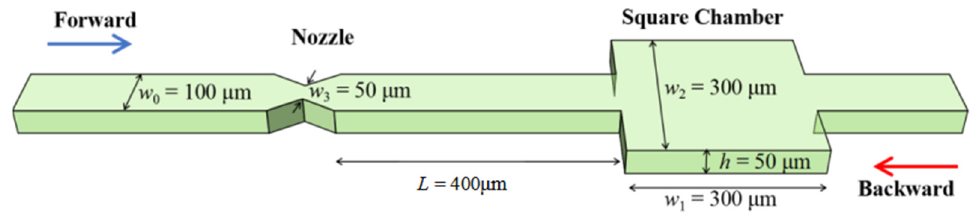
Figure 1. Schematic of microchannel consisting of a square chamber and nozzle structure. The streamline of the flow was recorded under a microscope by adding polystyrene tracking particles with a diameter of 1 µ m in a concentration of 0.6 µ L/mL. The flow pattern was studied at different flow rates and, therefore, different Wi numbers for the viscoelastic fluid. The Weissenberg number, defined as Wi = λ U / L , describes the elasticity of the flow and qualifies the nonlinearity of the fluid, where L is the characteristic length of the channel, U is the flow rate in the channel, and λ is the relaxation time of the fluid, referring to the characteristic stretch–relax time of the polymer, which was measured as ~0.1 s for the PAM of 500 ppm. The Reynolds number is used to characterize the relationship between the inertial and viscous forces in the Newtonian fluid, expressed as Re = ρ UL / η , where ρ is the density of the fluid.